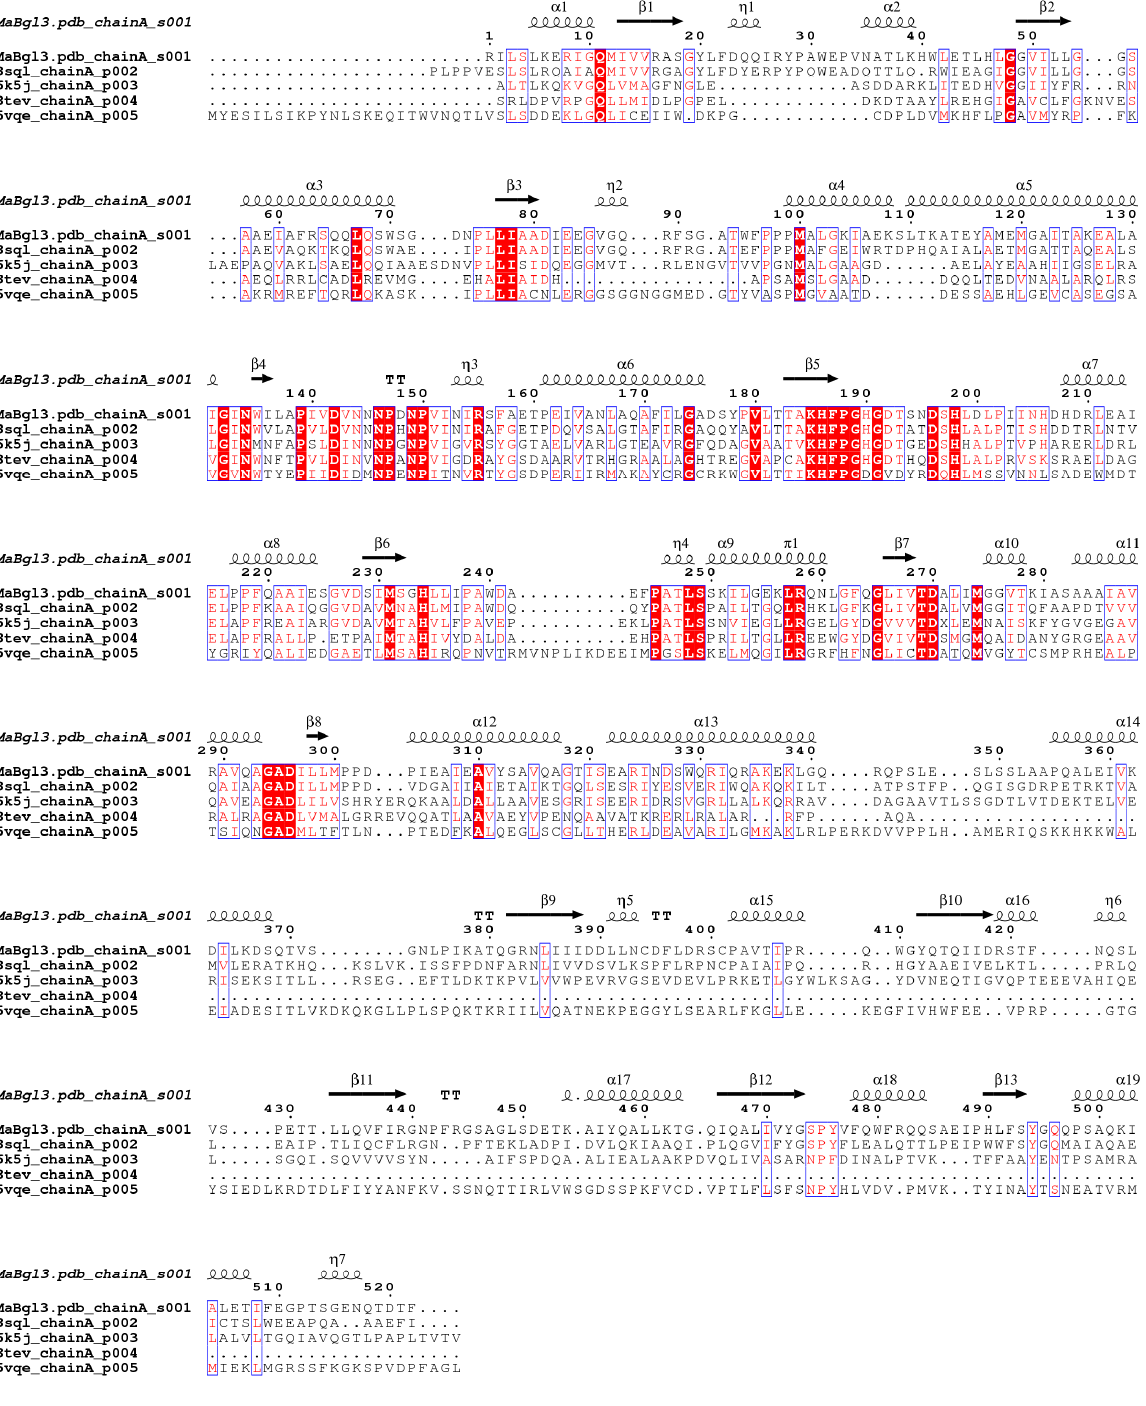
Figure 1. Alignment of the MaBgl3 sequence with selected ones from PDB. (Denoted according to PDB identification and identity percentage PDB ID: 3SQL—glycoside hydrolase from Synechococcus